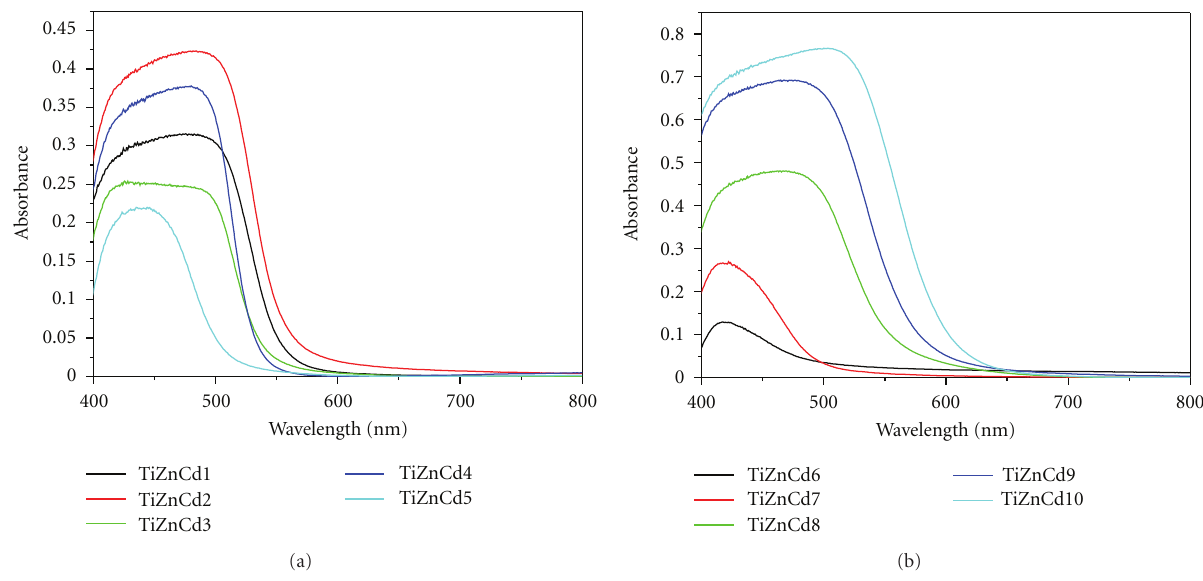
Figure 8: UV-VIS absorbance spectra of prepared TiZnCd samples.